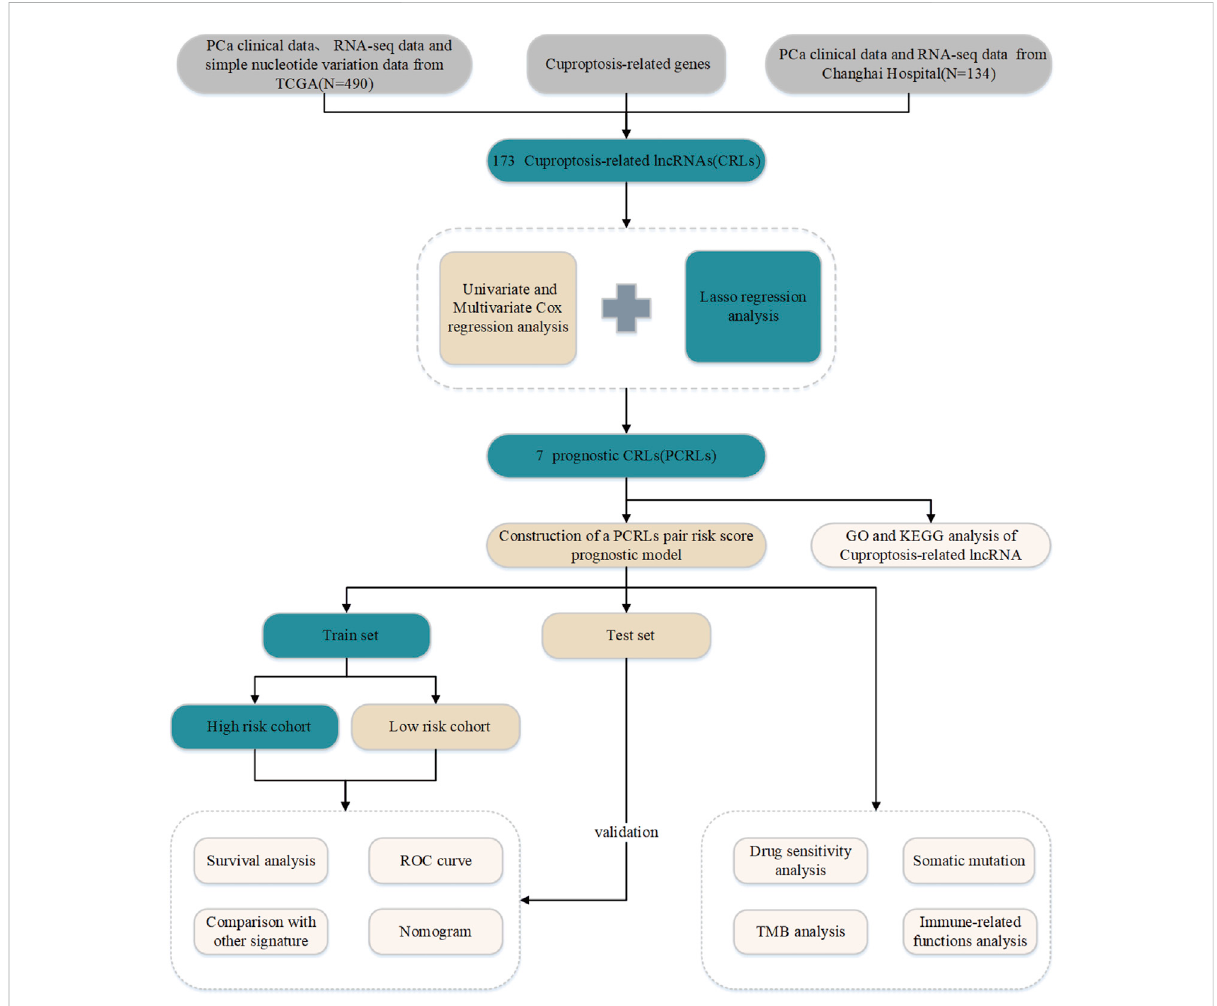
FIGURE 1 Flow chart of the study. TCGA: The Cancer Genome Atlas; PCa: prostate cancer; lncRNAs: long noncoding RNAs. GO: gene ontology; KEGG: Kyoto Encyclopedia of Genes and